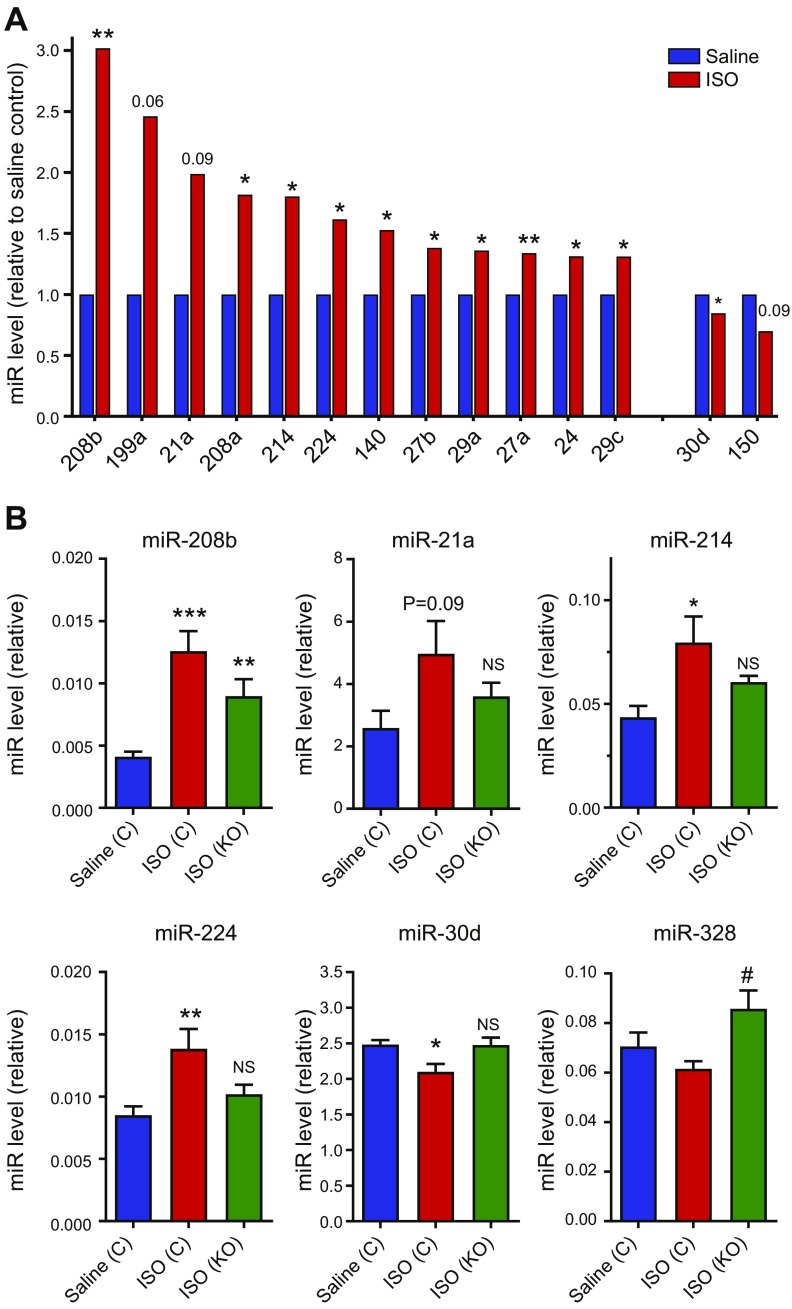
Effect of fibroblast-specific p38α KO on isoproterenol-induced miRNA expression. Control or Fb-p38α KO mice were injected with tamoxifen and infused with saline or ISO as described in Figs. 2A and 3 legend. Heart tissue was collected 1 wk after removal of miniosmotic pumps and expression levels of 84 cardiovascular miRNAs determined using a real-time RT-PCR array. Group sizes: n = 4. See Supplemental Table 1 for full data set. A) miRNAs (miR) increased or decreased following ISO infusion. *P < 0.05, **P < 0.01 for effect of ISO (unpaired Student’s t test). B) miRNAs modulated by fibroblast-specific p38α KO. *P < 0.05, **P < 0.01, ***P < 0.001 (ANOVA with Šidák post hoc test). NS, not significant, compared with control saline group. #P < 0.05, compared with control ISO group. Data expressed relative to array-normalization controls.